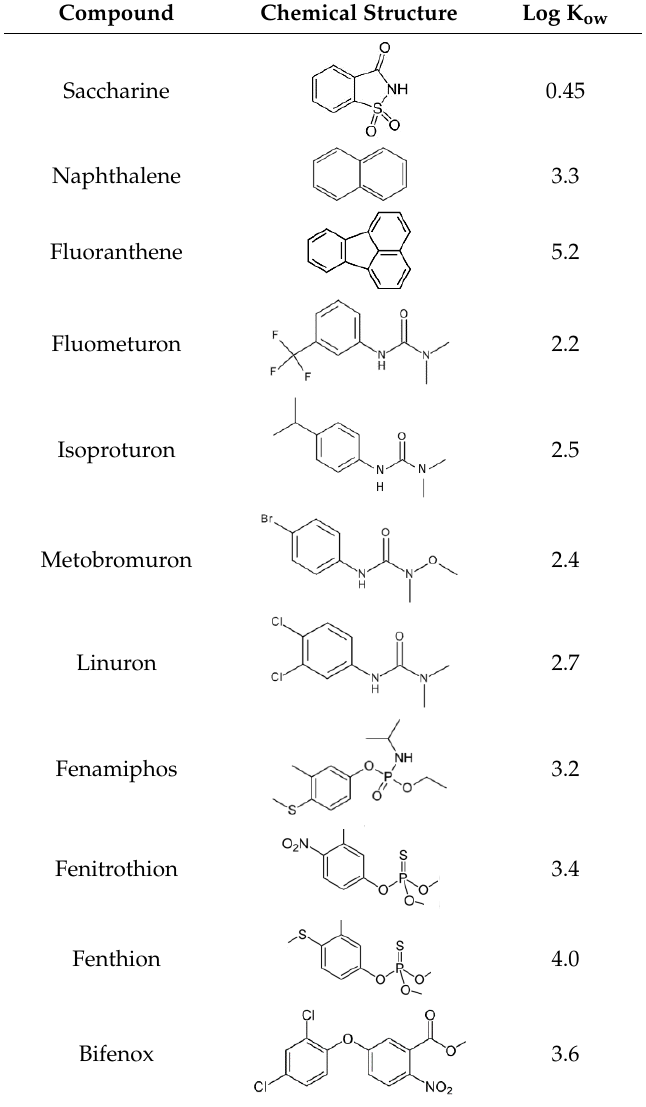
Table 1. Chemical structures and log K ow of the tested compounds.